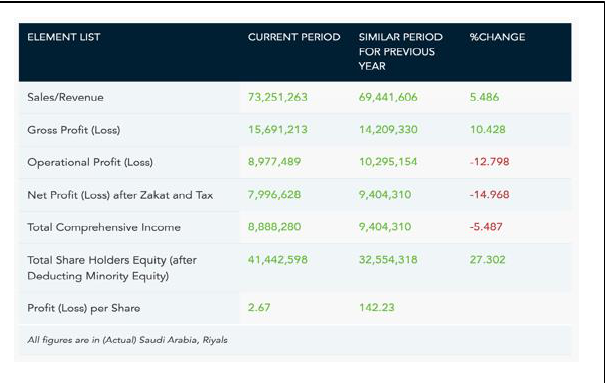
Figure 2. A sample of annual financial results companies release and Tadawul publishes.